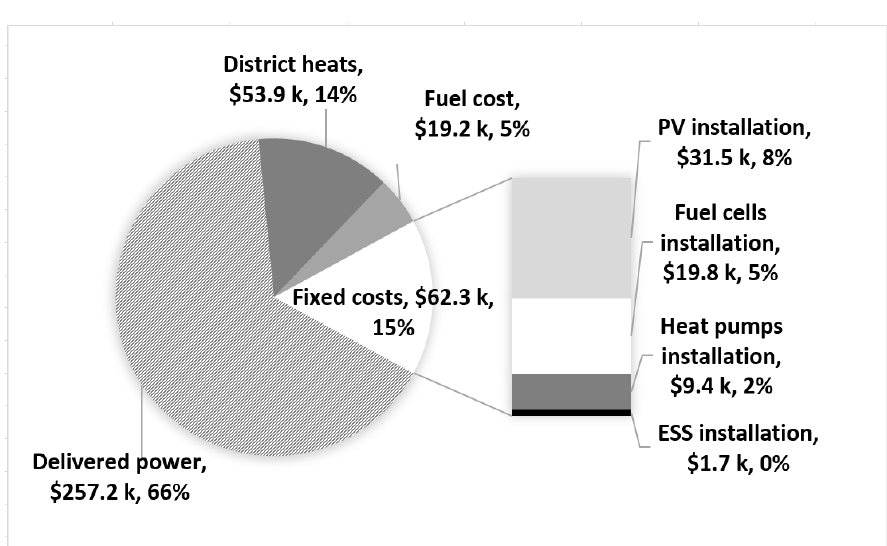
Figure 2. The annual energy supply cost analysis results for Case